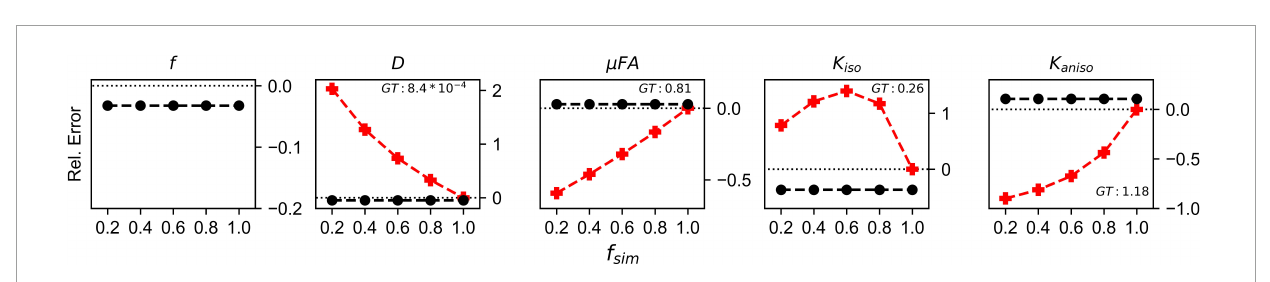
FIGURE4 Relative error in diffusion MRI indices measured using the conventional (Conv) and FWE methods on signals simulated using a Monte Carlo technique. The geometry consisted of infinitely long cylinders with a 1 µ m radius and 0.7 intra-tube fraction. The x -axis depicts the simulated volume fraction ( f sim ), while the ground truth value for each metric is denoted as GT. The red line with crosses indicates the measurements made using the conventional (Conv) method while the black line with circles indicates measurements made using the FWE